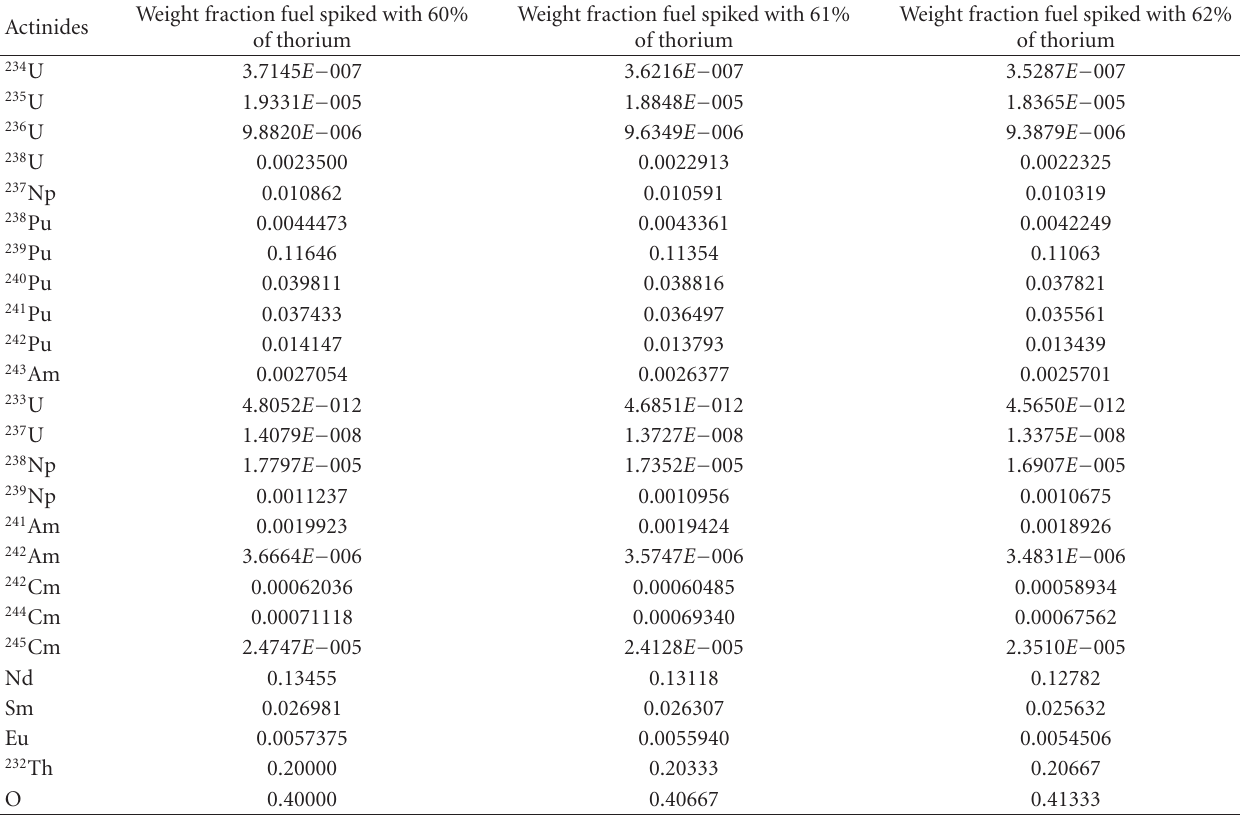
Table 3: Fuel composition (normalized) for the reprocessed fuels spiked with thorium.